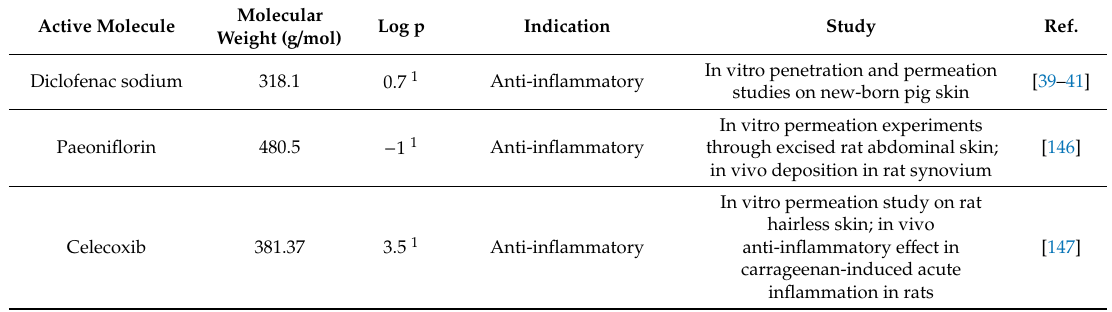
Active molecules incorporated in glycerosomes investigated for dermal / transdermal administration: in vitro and in vivo in animal studies (presented in chronological